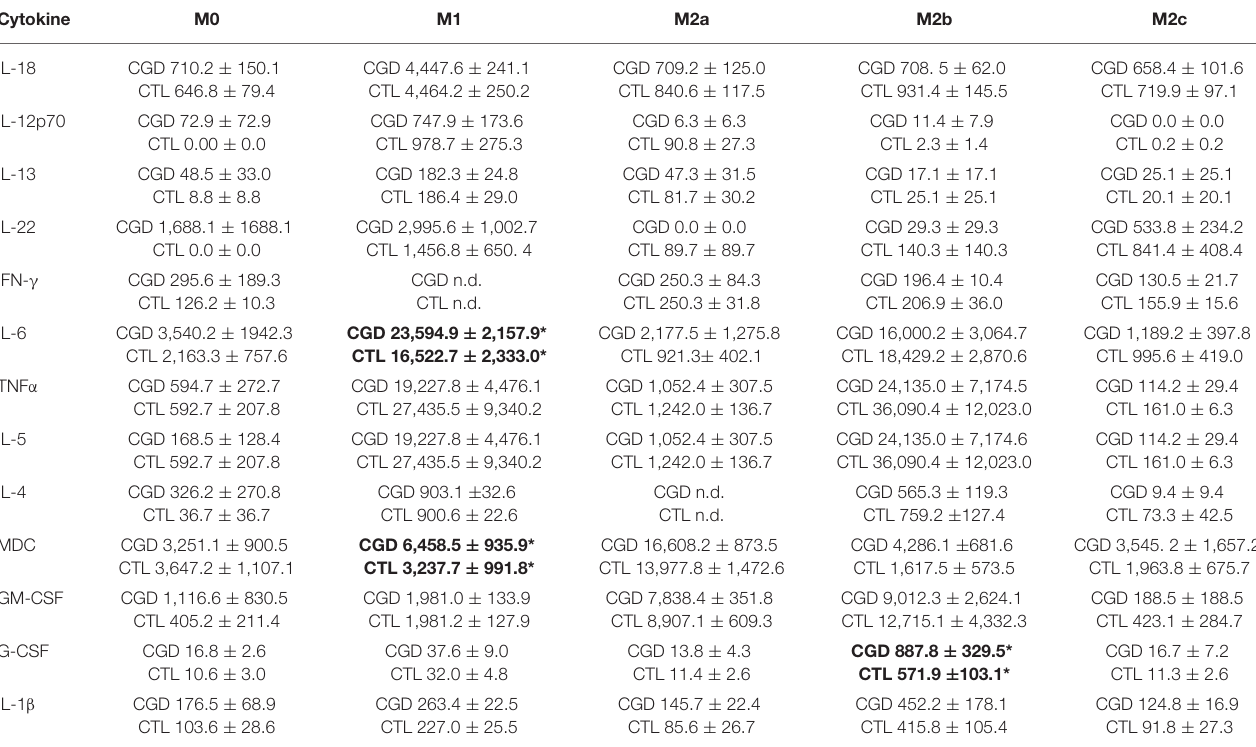
TABLE 2 | Cytokine/chemokine secretion of CGD macrophages compared to control upon 24h priming. Cytokine